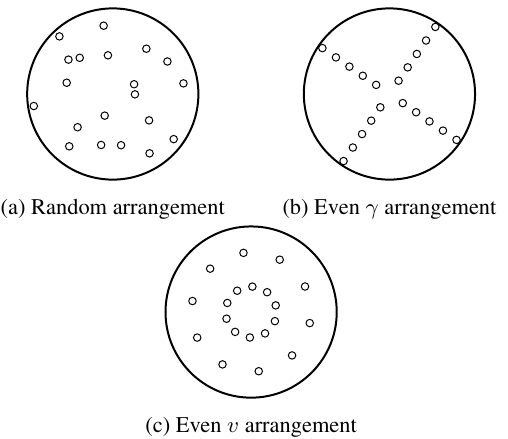
Figure 2. Three control configurations. Each configuration con- sists of 20 points Noise